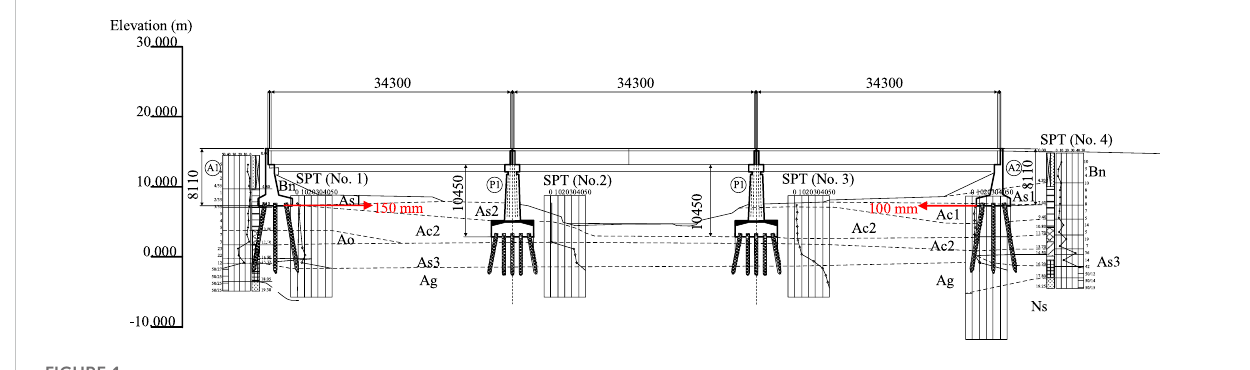
FIGURE 1 SideviewofNishikawaBridgelocatedinMiyagiPrefecture,Japanwithgeologicalcrosssectionandstandardpenetrationtestdata(unit:mm;Bs,Bn: